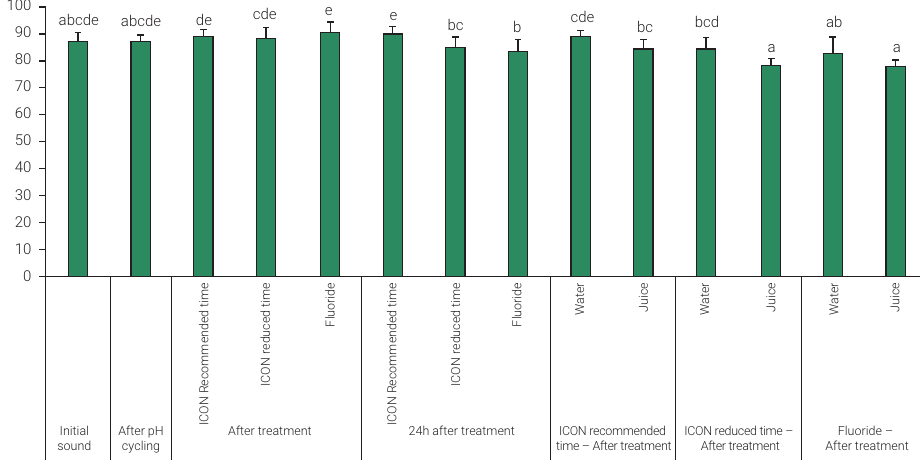
Figure 1. Graphic representation of L* mean values and standard deviations. Different letters indicate statistical significant difference (p <